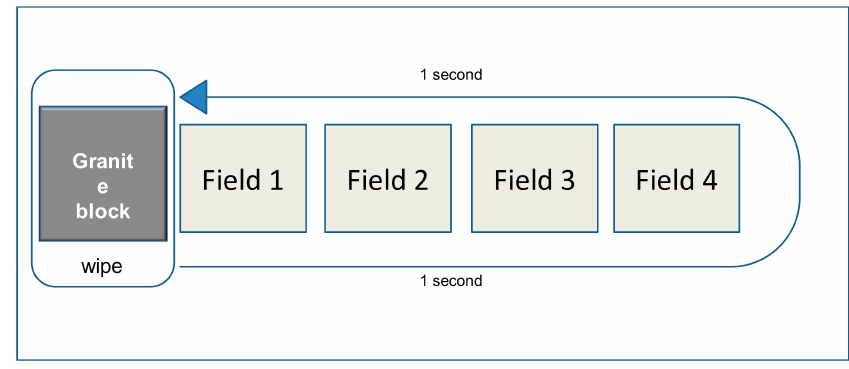
Figure 1. 4-field test—description in text